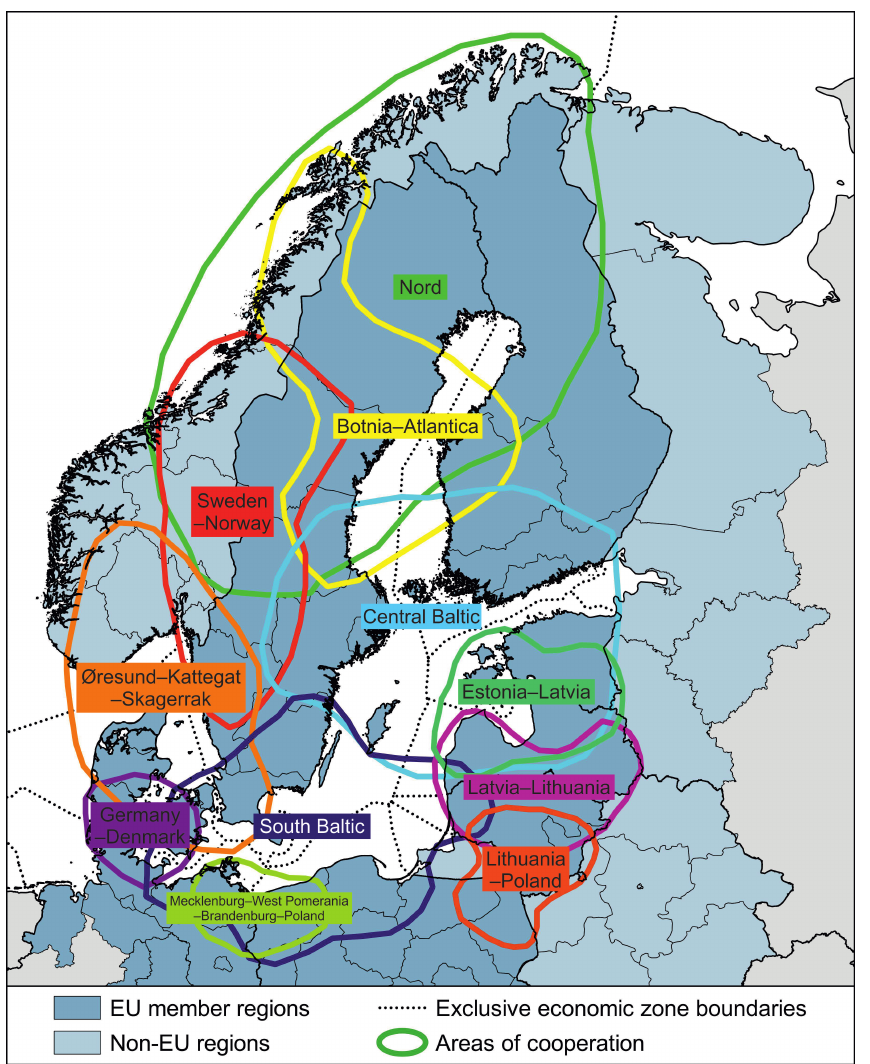
Figure1. Thedecision-makingprocessoftheproposedLa-ACC,wherethedrivingdecisionistaken usingthelook-aheadorpredictedstatesandthebasicmodelofACC. Figure 10. Map of BSR cross-border programmes in 2014–2020. Source: own study based on [50]. Each of the ETC programmes provided a different option for energy transition un- dertakings. This variation stemmed from the programmes’ architecture and relations between determinants of cooperation such as specific objectives, investment priorities, and intervention priorities (Figure 11).